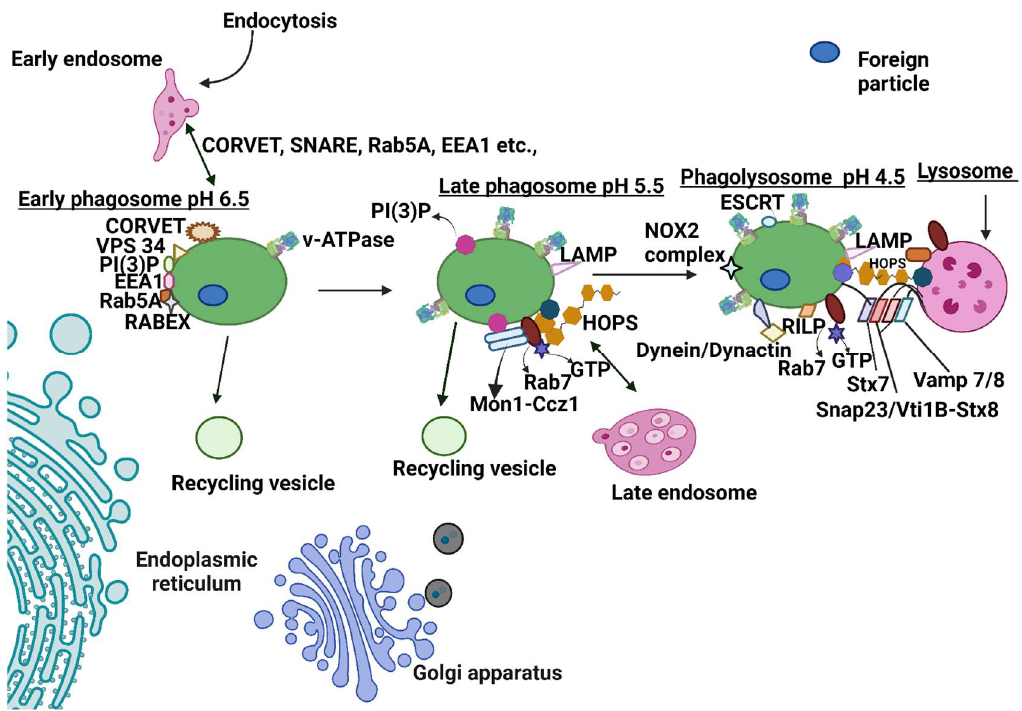
Figure 2. Schematic representation of phagosome maturation in parallel with endosome maturation. Phagosome maturation involves continuous fusion and fission events with early endosome, late endosome, lysosome, and recycling vesicles that cause the acquisition and loss of different markers of maturation. Following early phagosome formation, sequential steps form late phagosomes and phagolysosomes. The early phagosome is marked by the presence of Rab5, EEA1, VPS34, and PI(3)P. PI(3)P and GTP-bound Rab5 promote the recruitment of EEA1 that facilitates fusion between early phagosomes and early endosomes. Activated Rab5 also recruits the CORVET complex to promote fusion with the early endosome. The late phagosome is marked by the presence of Rab7 and LAMPs. In the late phagosome, PI3P recruits and activates the GEF, Mon1-Ccz1 complex, and activates Rab7. HOPS also activates Rab7 in the late phagosome. Rab7 is essential for phagolysosome fusion. The trans-SNARE complex also mediates the fusion between the late phagosome and lysosome. HOPS guides the late phagosome to the lysosome and stabilizes the trans-SNARE Stx7-Snap23-Vamp7/8 or Stx7-Vti1b-Stx8-Vamp7/8. The phagolysosome is rich in many degradative enzymes such as pro- teases, cathepsins, lysozymes, and NADPH oxidase complex. V-ATPase also accumulates and makes the lumen more acidic as the phagosome matures. 4.1. Early Phagosome: Fusion of Early Phagosome with Early Endosome The early phagosome is mildly acidic (pH 6.5) with poor enzyme activity [93]. The first step after early phagosome formation is interaction with the early endosome. Rab GTPase acts as a molecular switch between an active (GTP-GEF bound state) and an inac- tive state (GDP-GDI bound state). Rabs are recruited and activated in the cytosol by the guanine exchange factor (GEF–displace GDP with GTP), while they are inactivated by the GTPase activating protein (GAP’s- hydrolyze GTP to GDI) present in the vesicular mem- branes. Once activated, they are moved to the vesicle membrane. The active RabGTP binds to effector proteins that regulate several steps in phagolysosome fusion or maturation [94]. The early endosome is loaded with several proteins such as Rab5, EEA1, SNARE, PI (3)P, and Rab 22a, along with GEFs such as RABEX-5 and Rabaptin-5 [13,95]. RABEX-5 and Rabaptin-5 (acts as a GEF) are acquired by the nascent phagosome and promote the activation of Rab5. Rabaptin-5 also recruits other molecules such as Vps34 (class III phos- phoinositide 3-kinase vacuolar protein sorting 34) that enhance PI3P accumulation on the phagosome. PI3P and activated Rab5 recruit EEA1, promoting fusion of the early phago-